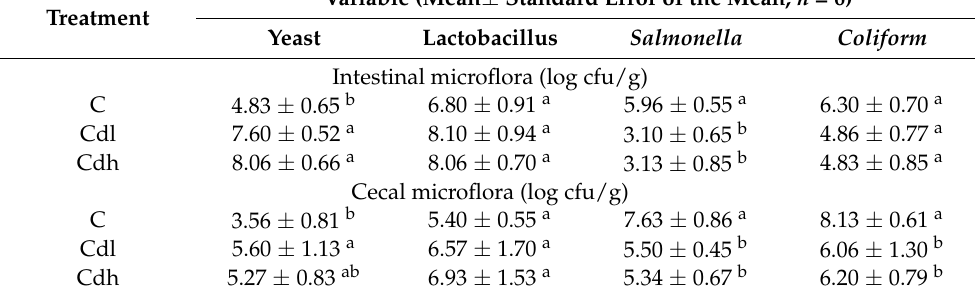
Table 8. Small intestinal and cecal microflora composition of rabbits treated with different concentra- tions of Cleome droserifolia (Forssk.) Del. (Cd) (0: C, Cdl: 1.25 g/kg of DM diet, or Cdh: 2.5 g/kg of DM